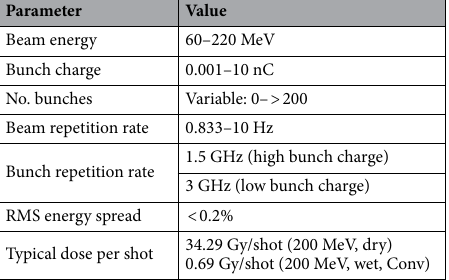
Table 6. CLEAR beam parameters primarily taken from Gamba et al. 21 and Sjobak et al. 22 Beam charge and repetition rate updated based on current